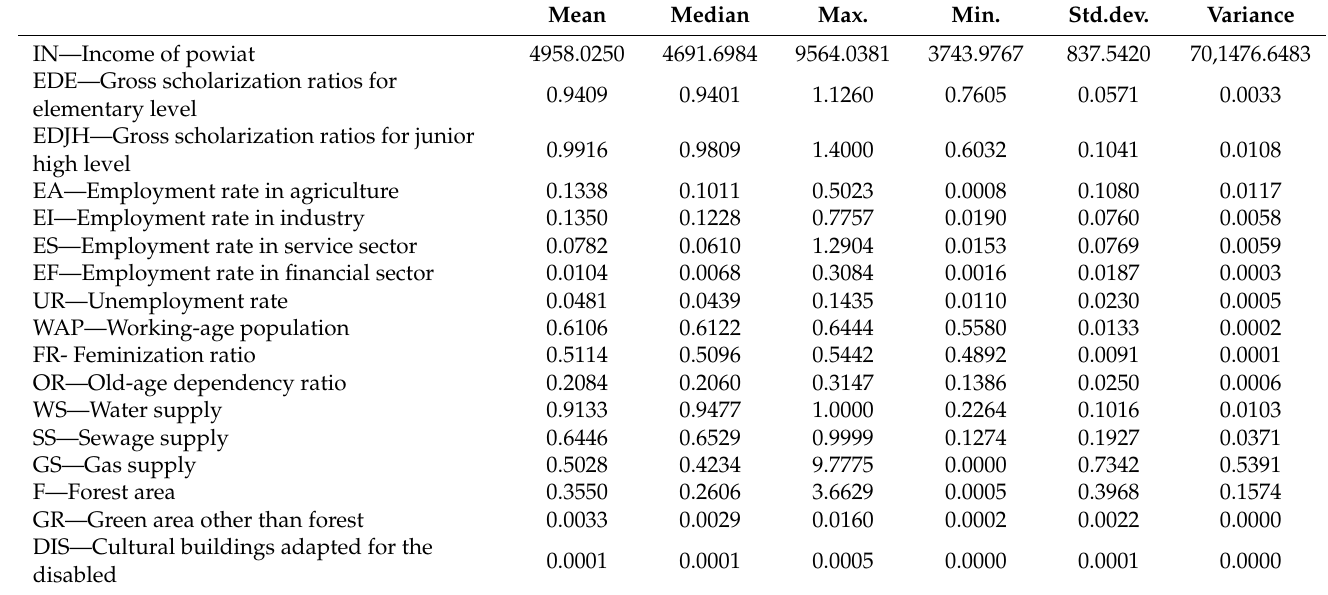
Table 4. Descriptive statistics of socioeconomic determinants of health in Poland. Mean Median Max. Min.